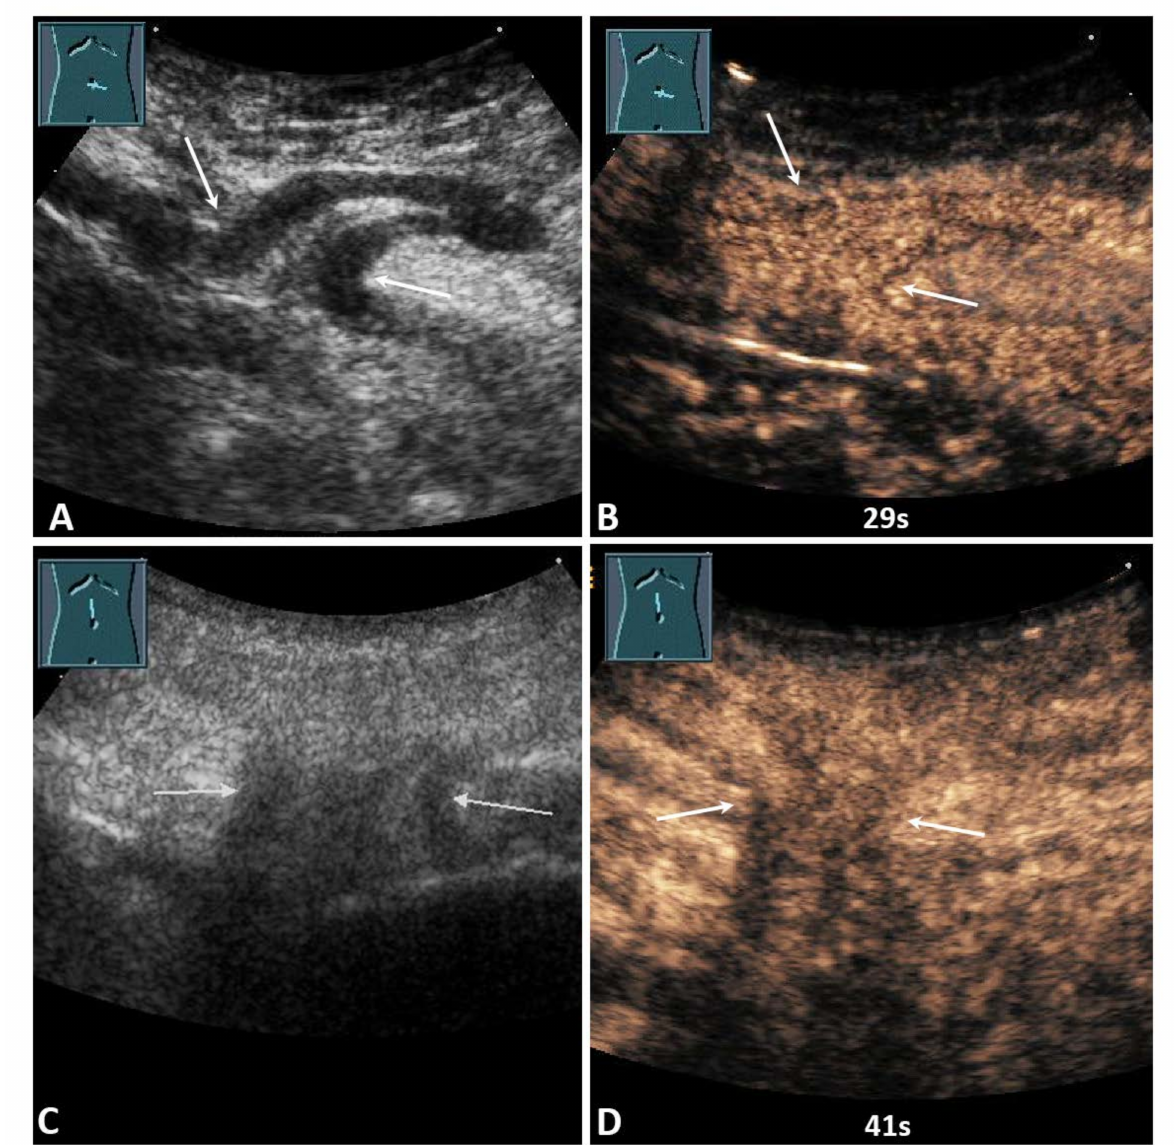
Figure 5. ( A ) A 59-year-old male patient with acute pain in the paraumbilical region. B-mode ultrasound shows a hernia orifice (arrows), and the hernia sac shows a fixed bowel structure. ( B ) On contrast-enhanced ultrasound, the loop of small bowel shows a marked enhancement after 29 s. Surgical evaluation showed no evidence of infarction. No resection of the bowel was performed. ( C ) A 91-year-old female patient with acute pain in the epigastric region. B-mode ultrasound shows a hernia orifice (arrows), and the hernia sac shows fixed omental tissue. ( D ) On contrast-enhanced ultrasound, the hernia contents show a marked enhancement after 41 s. Surgical evaluation showed no evidence of infarction. No resection of the omentum was